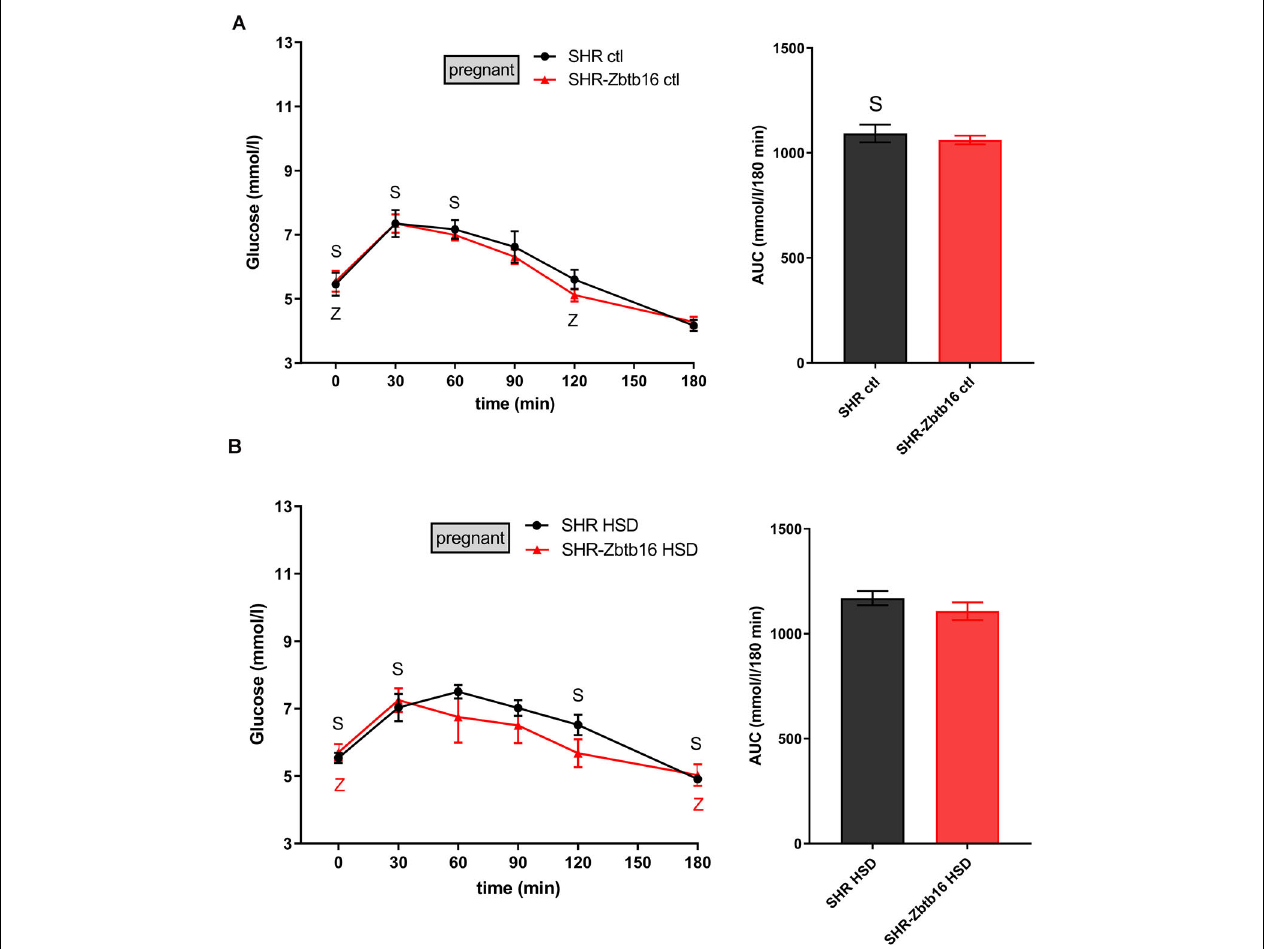
FIGURE 3 | The oral glucose tolerance test (OGTT). The course of glycemic curves in pregnant SHR females (black circles) and pregnant SHR- Zbtb16 females (red triangles) fed STD (ctl, A ) or fed HSD (HSD, B ) during OGTT with corresponding areas under the curves (AUC). Data are expressed as mean ± SEM. OGTT before pregnancy is shown in Supplementary Material . The significance levels of pair-wise comparisons (control before pregnancy vs. control in pregnancy vs. HSD fed in pregnancy) by repeated-measures two-way ANOVA (OGTT) and post-hoc Fisher’s test of the two-way ANOVA (AUC) with STRAIN and DIET as major factors are indicated as follows: ∗ p < 0.05, ∗∗ p < 0.01, ∗∗∗ p < 0.001. S represents differences in SHR – (A) t = 0 min ∗ , t = 30 min ∗ , t = 60 min ∗ , AUC ∗ , between control females before and during pregnancy; (B) t = 0 min ∗∗ , t = 30 min ∗∗ , t = 120 min ∗ , t = 180 min ∗∗ , between control females before pregnancy and females fed HSD during pregnancy. Z represents differences in SHR- Zbtb16 – panel (A) t = 0 min ∗∗ , t = 120 min ∗ between control females before and during pregnancy; (B) t = 0 min ∗∗ , t = 180 min ∗ between control females before pregnancy and females fed HSD during